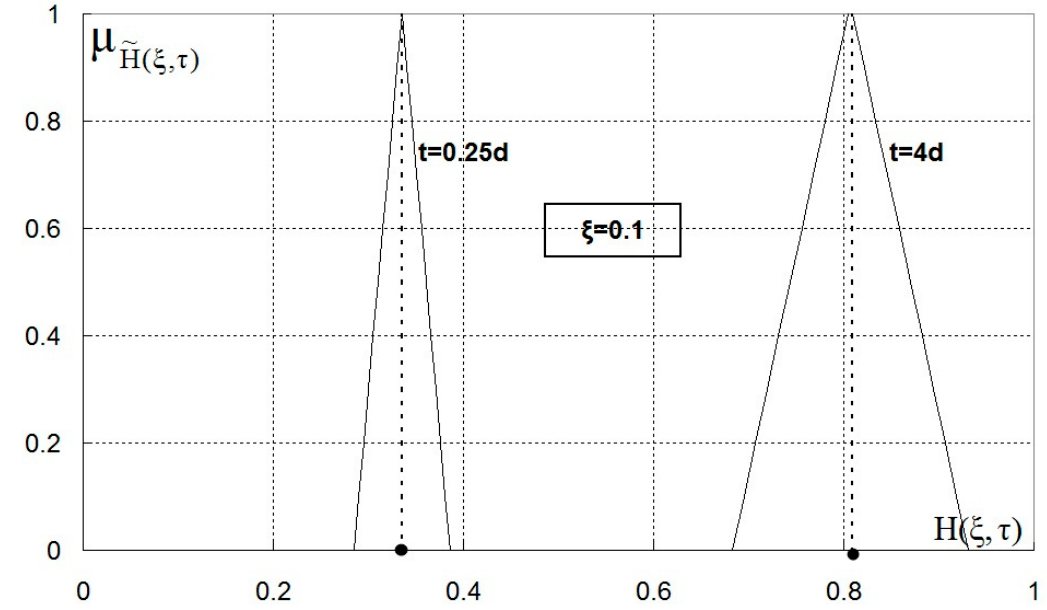
for t = 0.25 d, t = 4 d at ξ = H ( ξ , τ ) (cid:101)